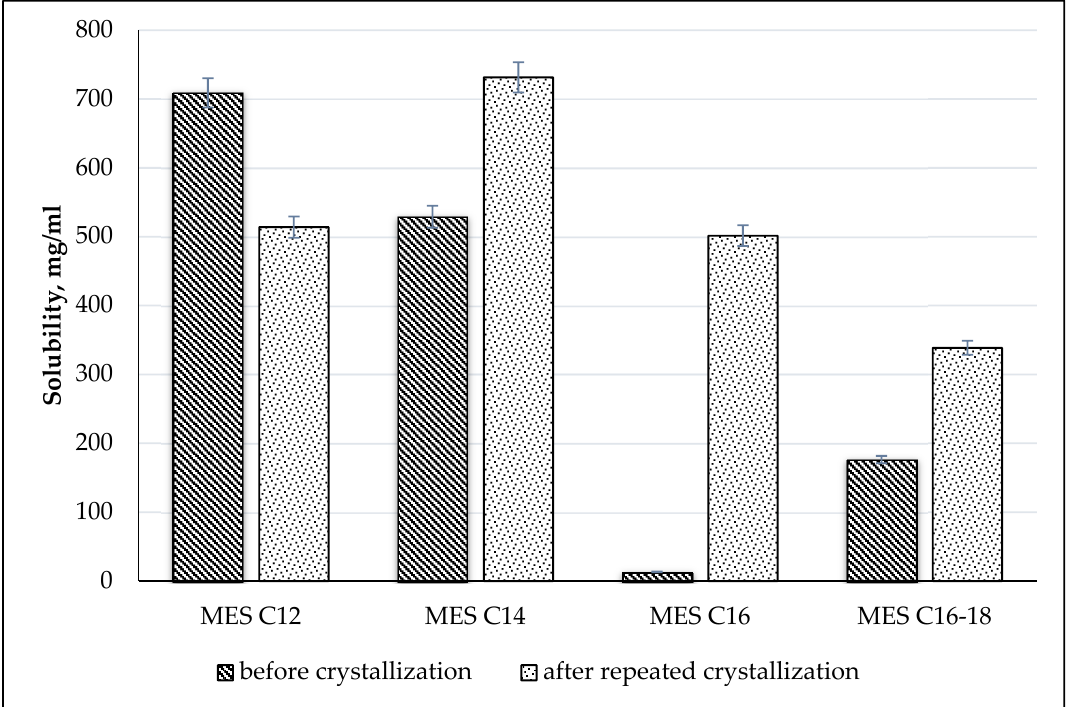
Figure 10. Solubility of MES with different active content in water.